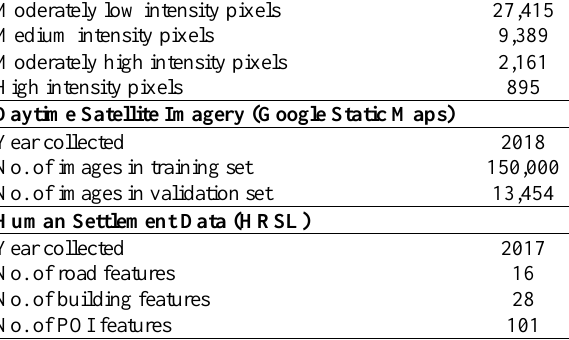
Table 2. Primary datasets used in this